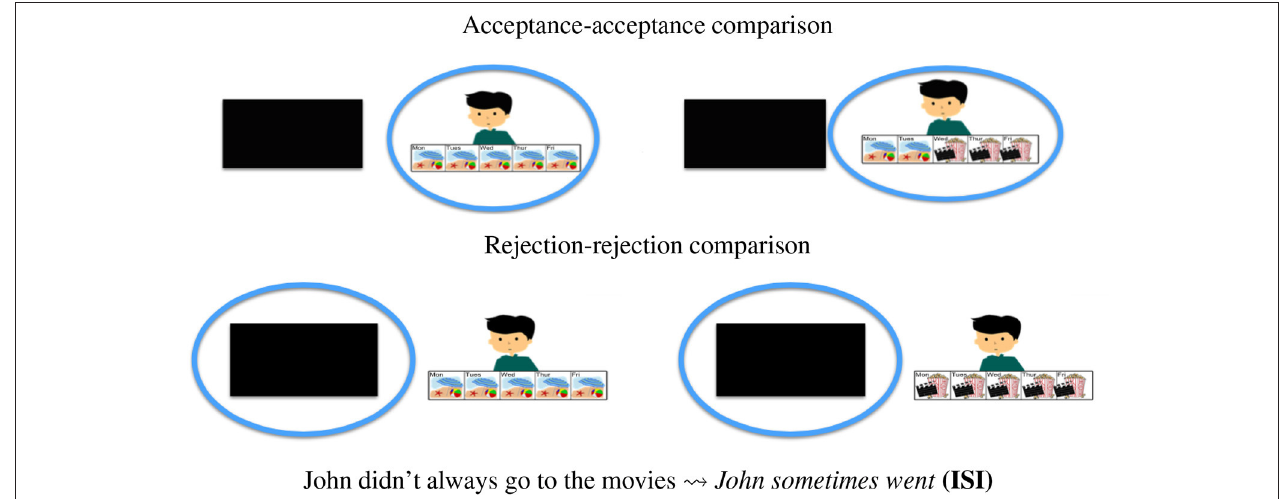
FIGURE 4 | Acceptance-acceptance and rejection-rejection comparisons for ISI sentences.